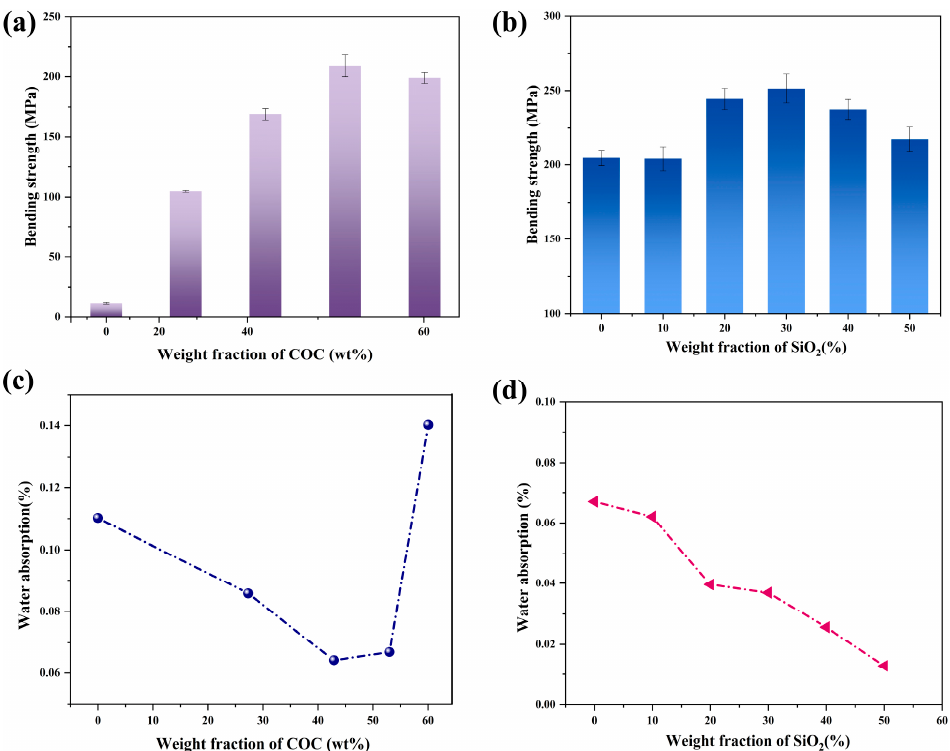
Figure 7. Influence of the content of COC ( a ) and SiO 2 ( b ) on the bending strength; water absorption of the samples ( c ) with different content of COC and ( d ) with different content of SiO 2 .